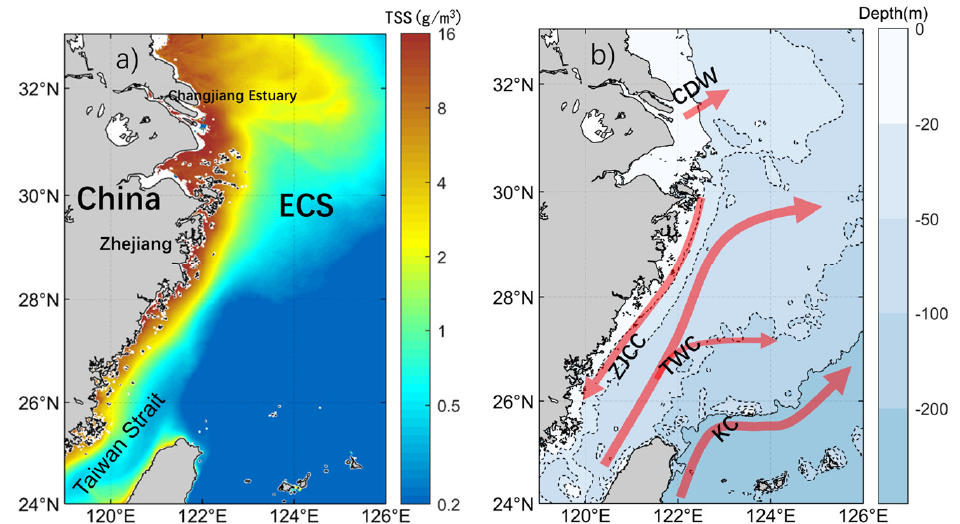
Figure 1. ( a ) Spatial distribution of GOCI climatological TSS in the East China Sea; ( b ) the schematic diagram of ocean circulation (the background color in ( b ) is the water depth). KC : Kuroshio Current; TWC : Taiwan Warm Current; CDW : Changjiang Diluted Water; ZJCC : Zhejiang Coastal Current.